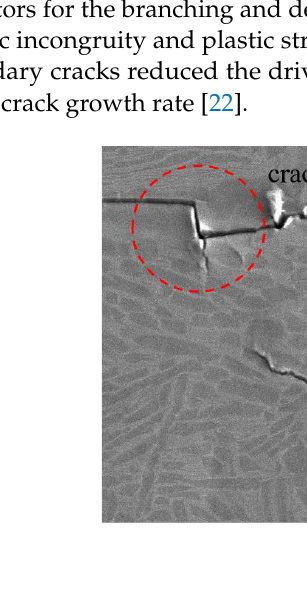
Figure 10. Morphology of secondary crack propagation on the side of fatigue specimen under different stress amplitudes. ( a ) 1000 MPa. ( b ) 950